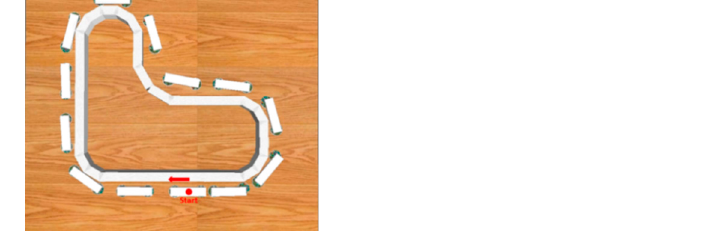
Figure 29. Wall-following control of cooperative carrying in the training environment.